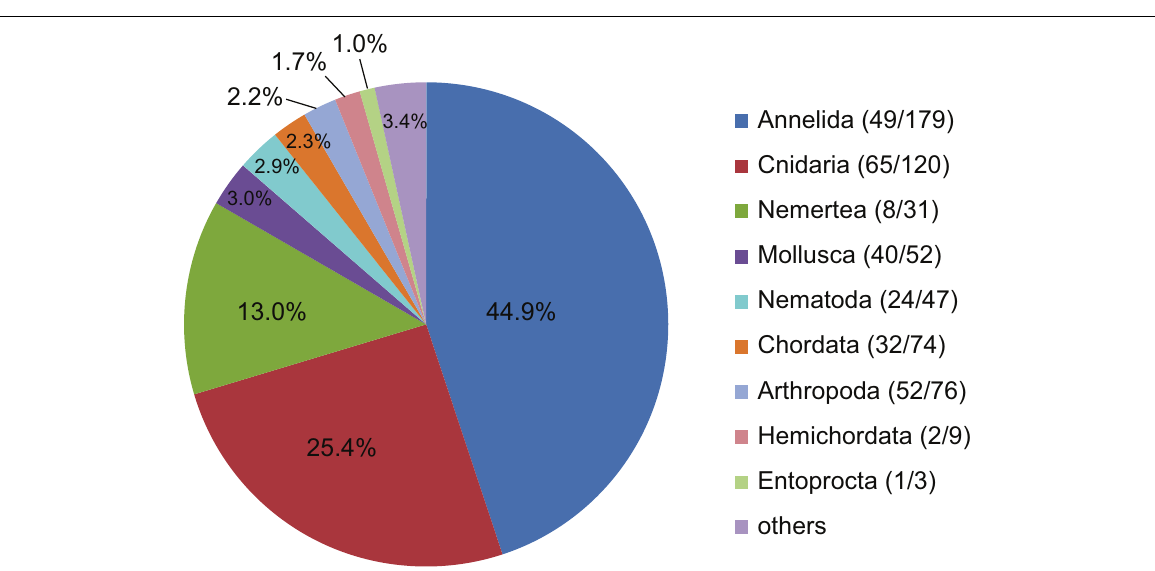
diversity are unknown in terms of the 18S rRNA sequences within both databases. Considering the importance of the reference database, the update of taxonomic classifications of each database is necessary to improve the taxonomic resolution in metabarcoding